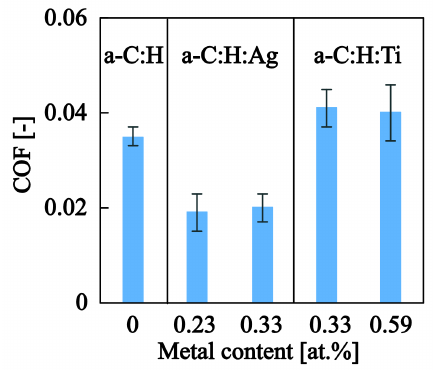
Figure 13. COF values for the a–C:H and a–C:H:Me films deposited in this study. The COF values reported correspond to the average values calculated within the elastic domain ( P < P y